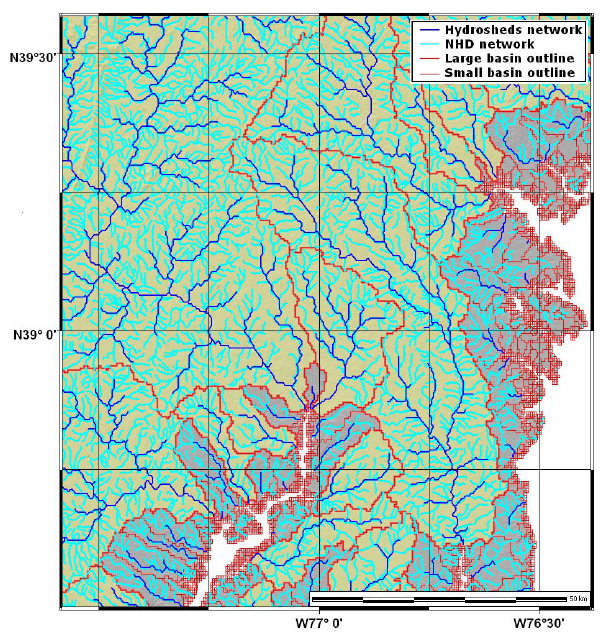
Fig. 2. Comparison of Hydrosheds and NHD drainage networks for part of the Chesapeake Bay